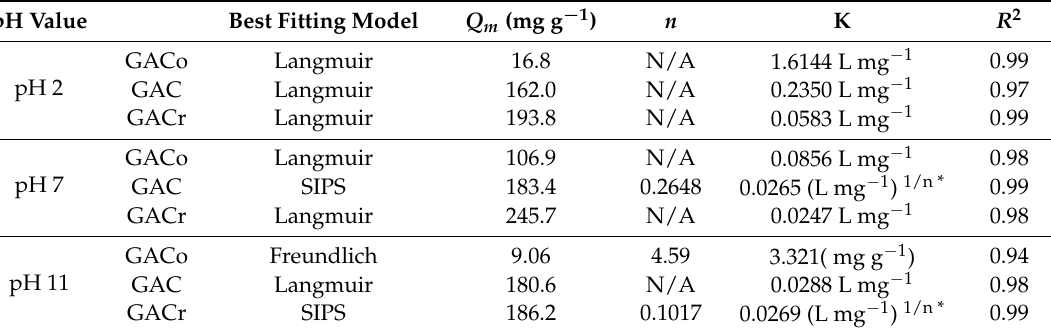
Table 3. Best model fitting and model parameters for paracetamol adsorption on GAC, GACo and GACr activated carbons at different pH